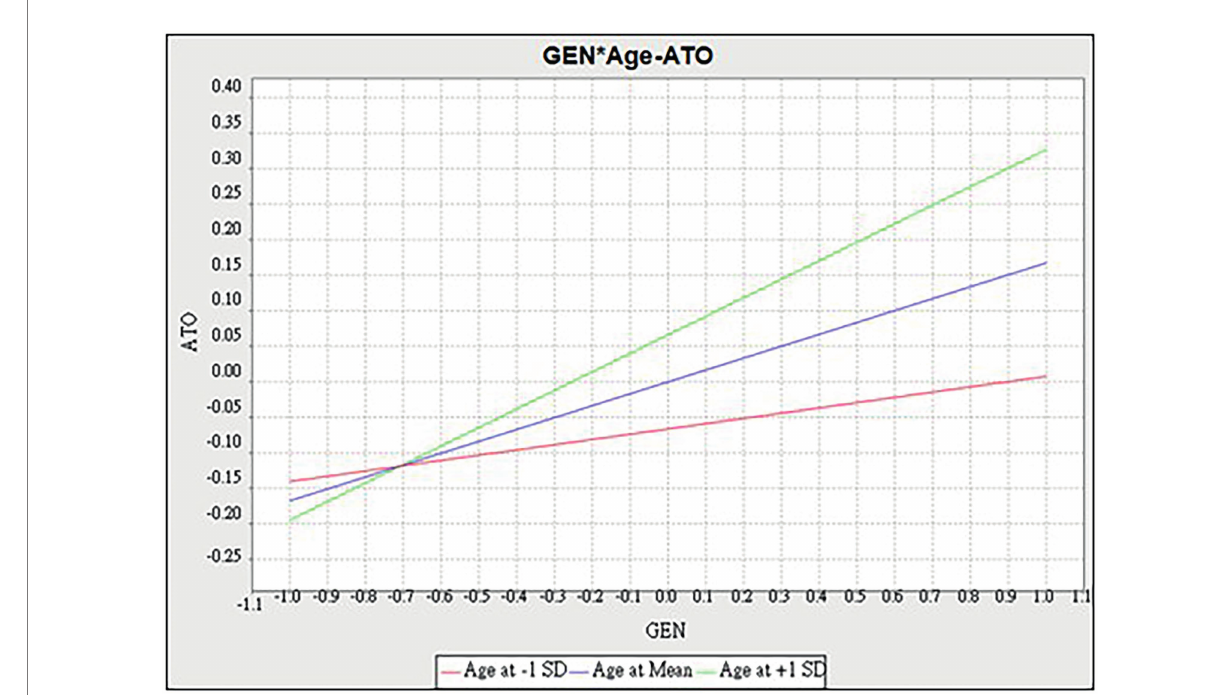
FIGURE 3 Moderating effect of age-generativity to